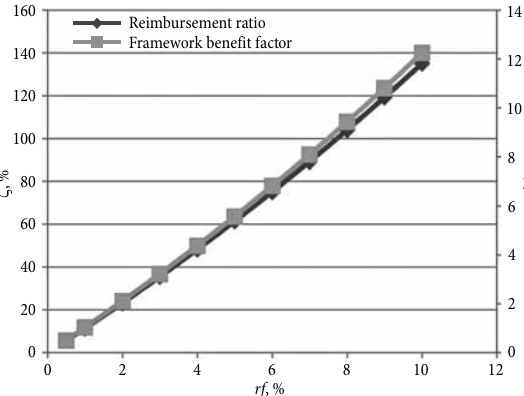
Fig. 5. Sensitivity analysis based on varying rf